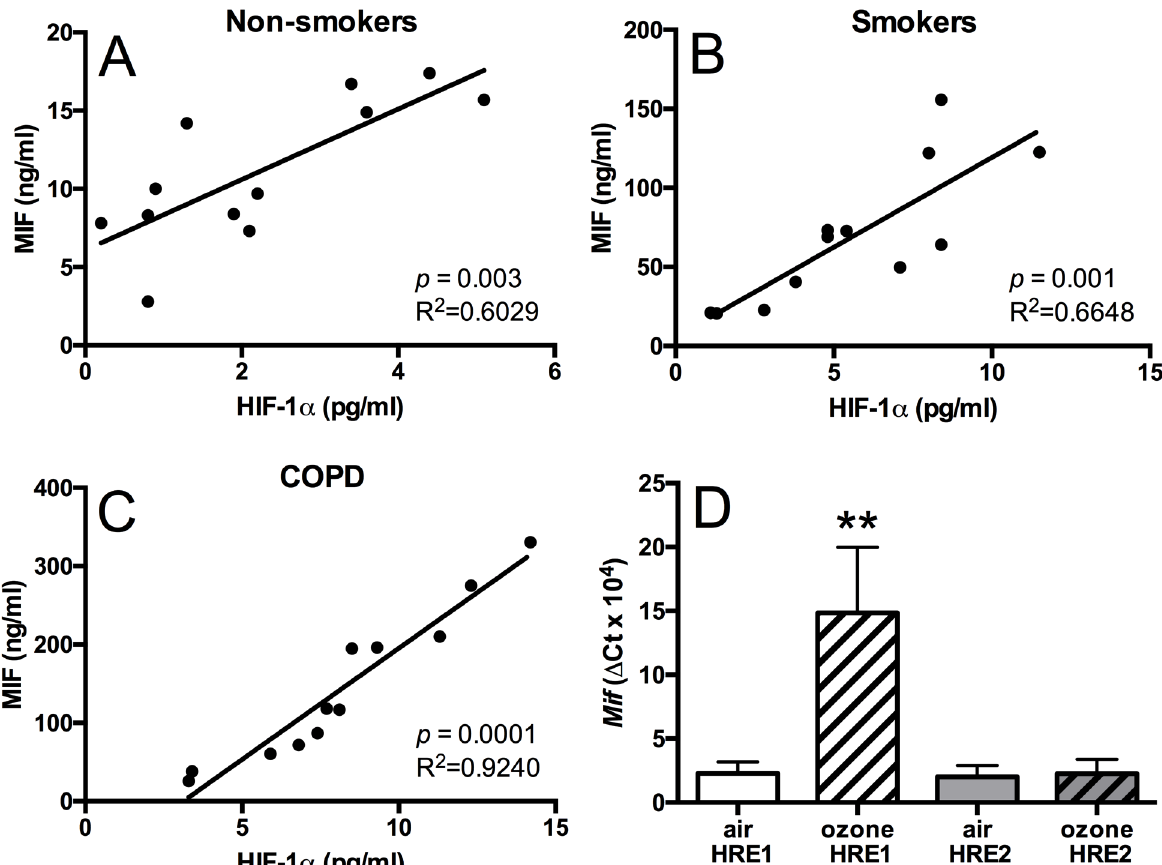
Fig 2. MIF and HIf-1 α correlations in COPD and HIF-1 α regulation of Mif expression. Correlation analysis between HIF-1 α and MIF protein concentrations in isolated BAL macrophages from non-smokers (A), smokers (B), and COPD patients (C). Chromatin immunoprecipitation analysis of HIF-1 α binding to HRE1 and HRE2 sites in the Mif promoter in mouse lung tissue (D). Data are expressed as mean ± SD for 6 animals per group. ** p < 0.01 compared to air